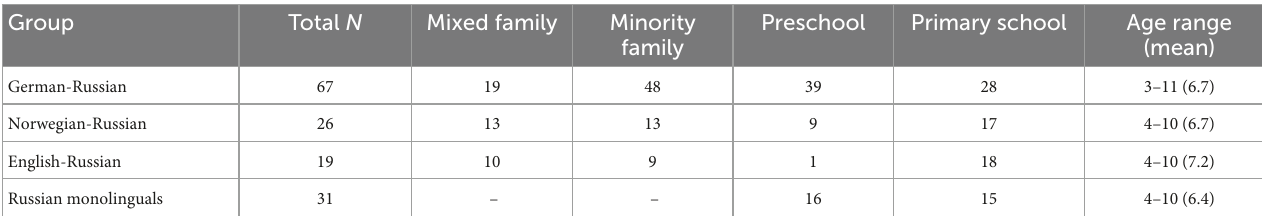
TABLE 1 Background information on the participants per group and family type. Group Total